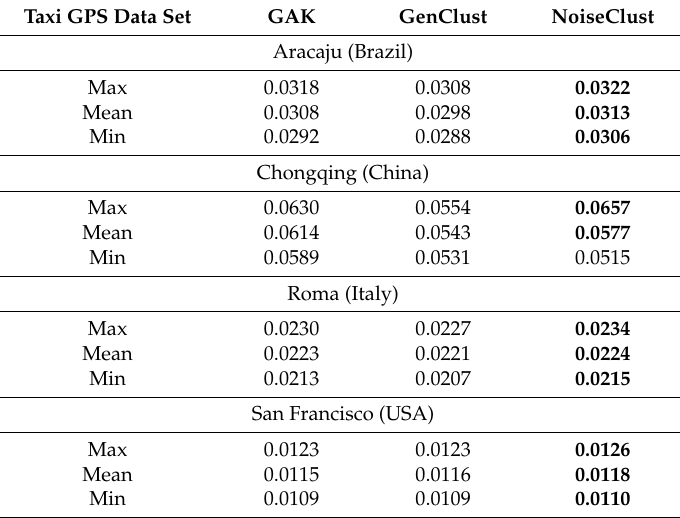
The bold font indicates the best value for taxi GPS data.